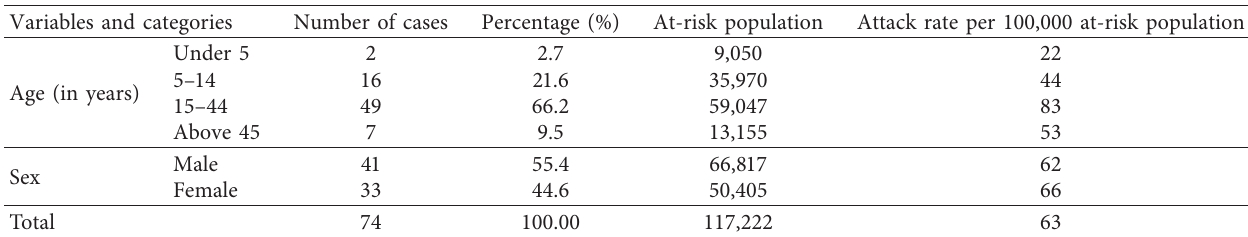
Figure 1: Distribution of chikungunya virus cases by date of onset of fever in Kebridahar City Administration, Somali, Ethiopia, 2019. Table 2: Distribution of chikungunya cases by the age group, Kebridahar City Administration, Somali, Ethiopia,